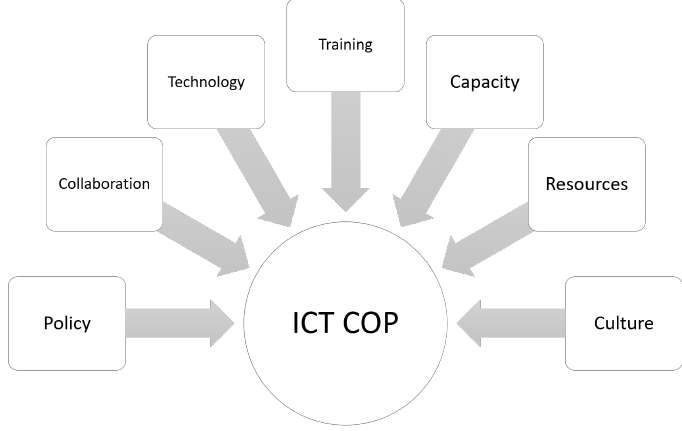
Figure 2. Factors affecting ICT for COP